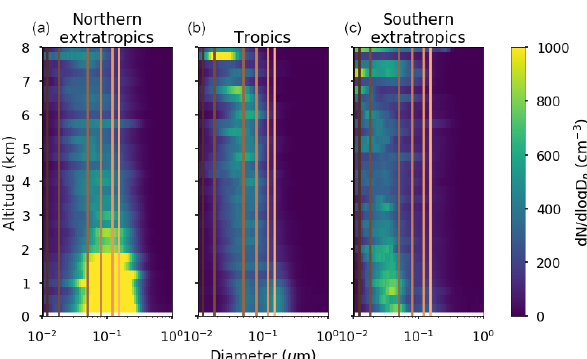
Figure 4. The vertical profile of integrated (a) model and (b) ob- served aerosol number at different size cut-offs. The lines represent the median over all points in that altitude bin, while the shading shows the interquartile range. Panel (c) shows the median fractional